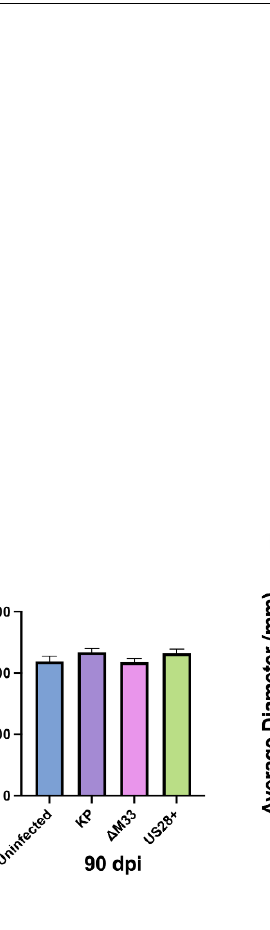
Figure 6. Cardiac function at 90 dpi. Mice were uninfected or infected with 1 × 10 6 PFU i.p. At 90 dpi, echocardiography was conducted: ( A ) average heart rate per group, ( B ) average left ventricular diameter, ( C ) average left ventricular posterior wall thickness were analyzed. Group mean and standard error of the mean were calculated. Significance was determined by ANOVA and Tukey’s multiple comparisons test. * p < 0.05. Studies were conducted in triplicate ( n = 15).